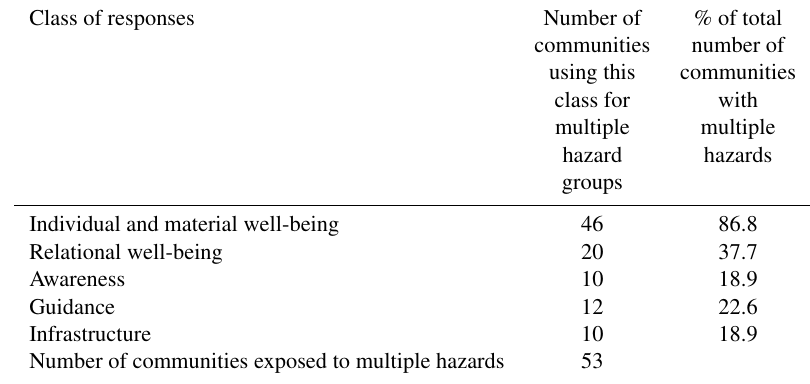
Table 6. Number of communities exposed to multiple hazards that have utilized a specific class of responses. Class of responses